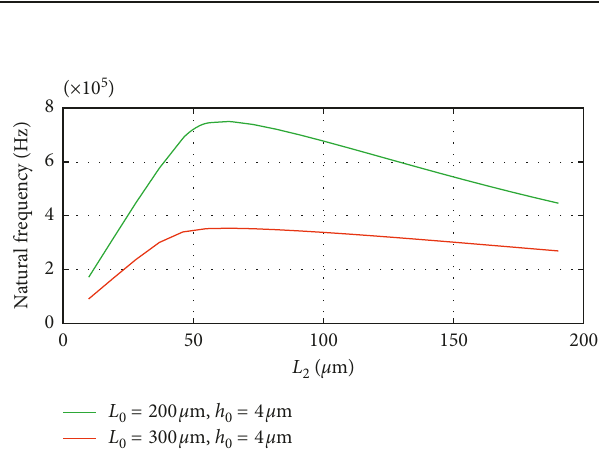
Figure 6: Natural frequency versus L